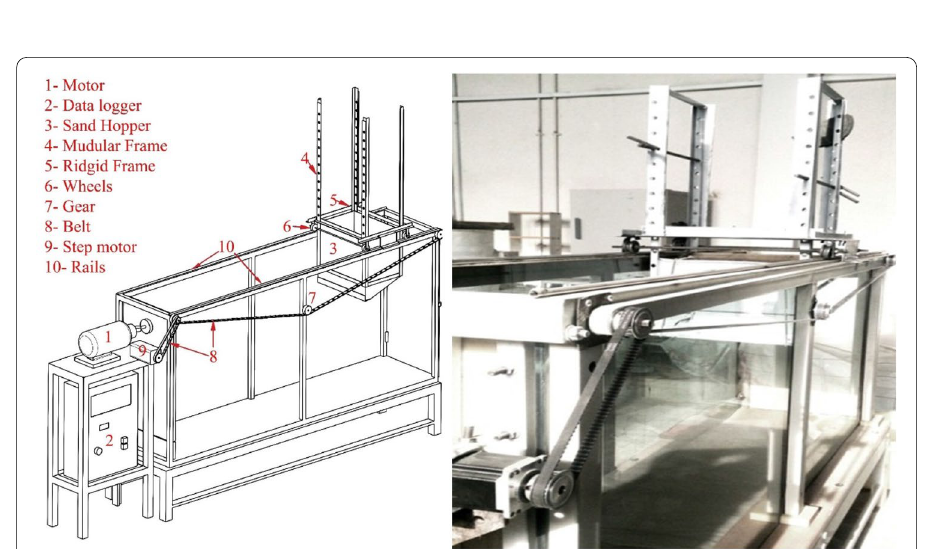
Fig. 7 Schematic view and picture of the sand pluviation system mounted on the model